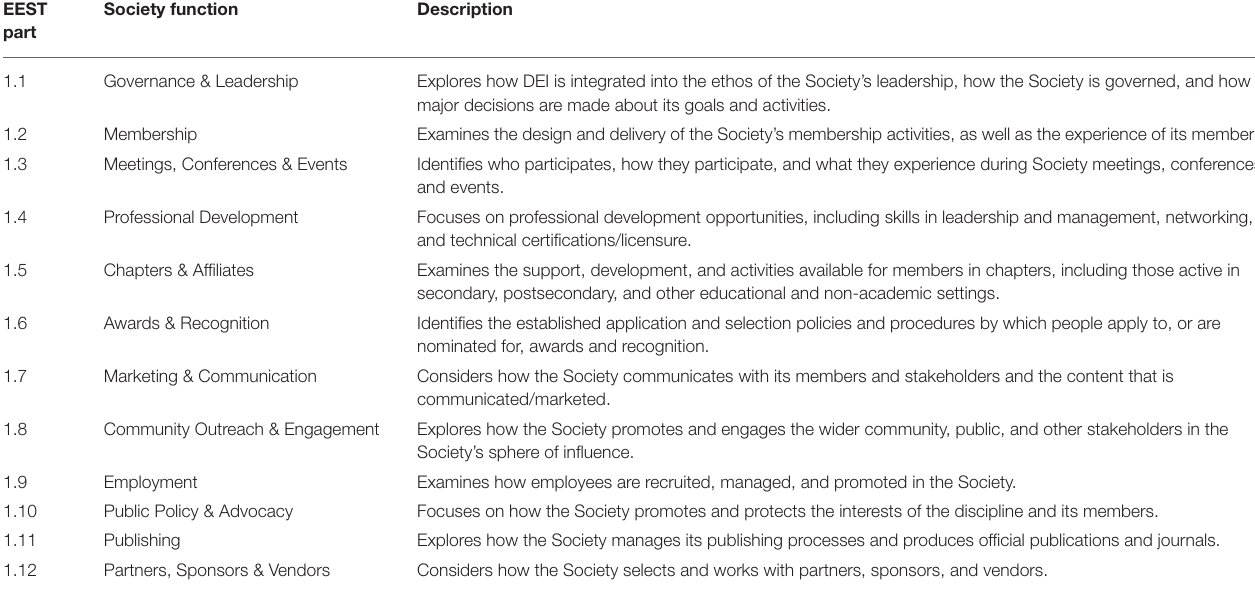
TABLE 1 | The EEST Part 1 twelve society functions and